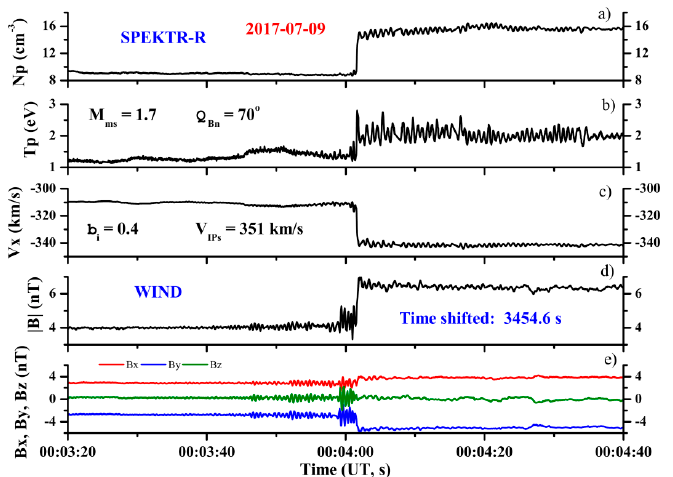
Figure 1. Time profiles of plasma parameters and magnetic field during the IP shock passage on 9 July 2017. From top to bottom: ( a ) solar wind density; ( b ) solar wind temperature; ( c ) solar wind velocity (along the Earth–Sun direction) of the ion flow; ( d ) magnitude of the magnetic field; and ( e ) the components of the magnetic field. Satellites’ coordinates (GSE coordinate system, Re): Spektr-R (27,45; 17,63; − 21,67); WIND (208,27; 85,10; −